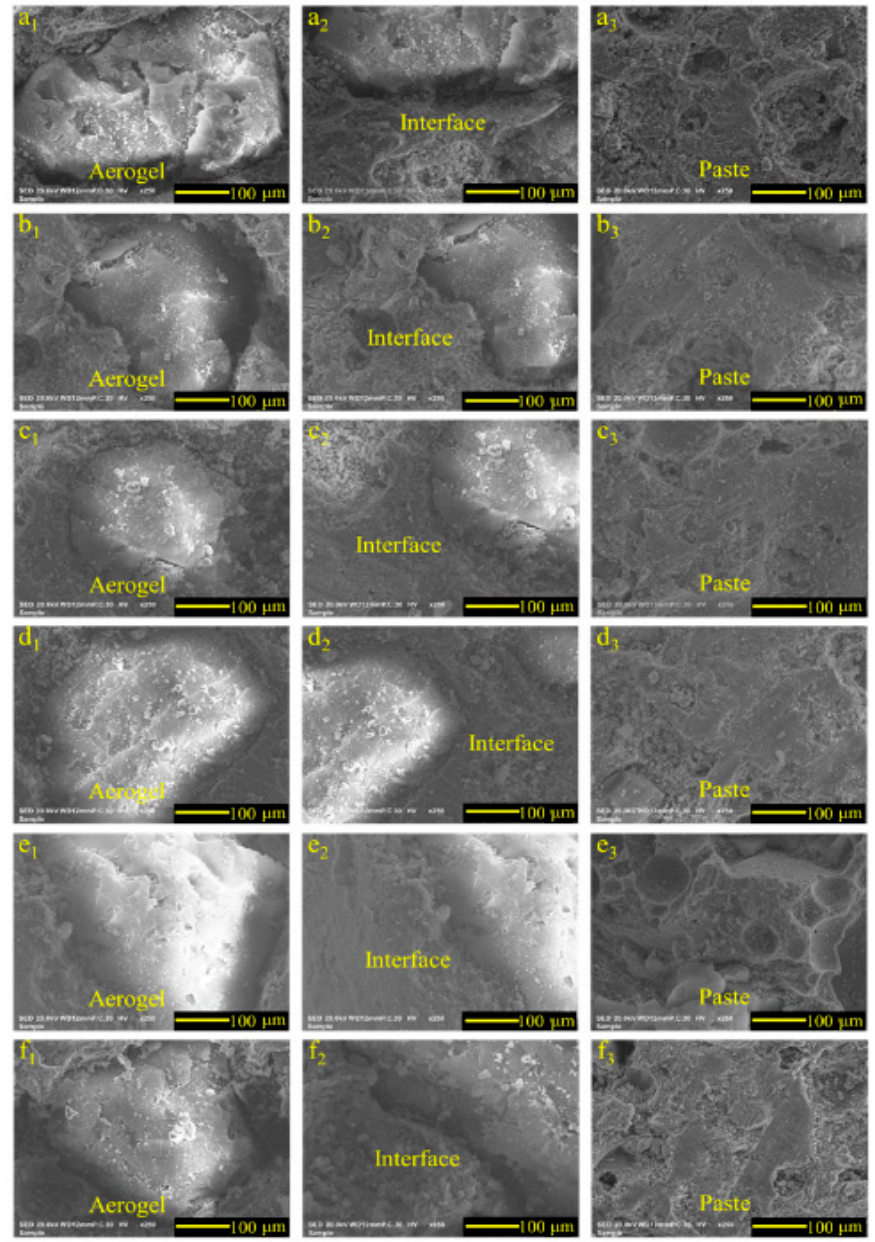
Figure 9. SEM images of ACP under different early curing regimes before the simulated tunnel fire: